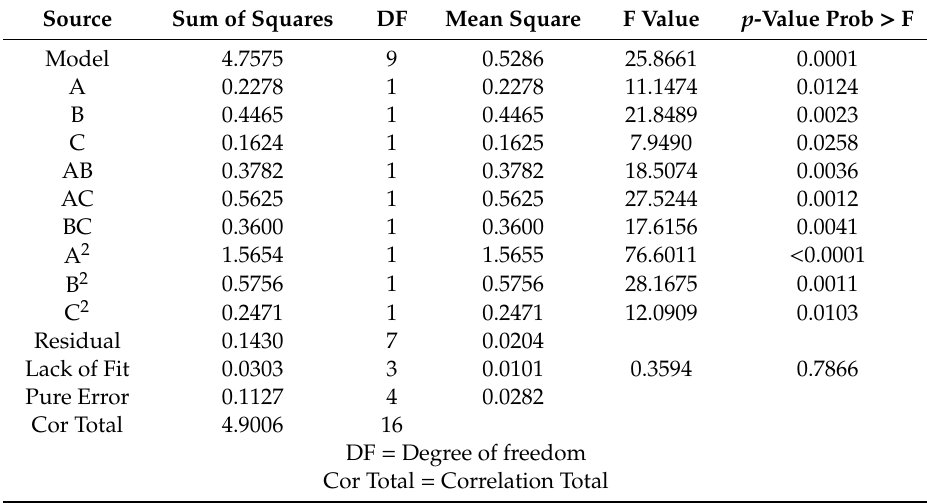
Table 3. The results of analysis on variance (ANOVA) for the e ff ects of variables. A, B, and C are extraction time, alcohol content, and ratio of liquor to material ( v / w ),